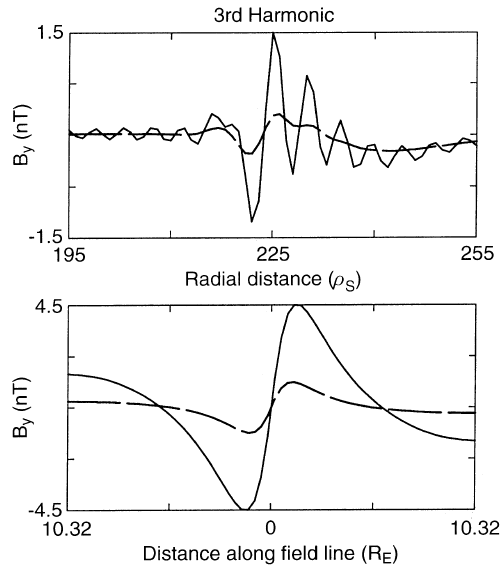
Fig. 3. Profiles of B y along the resonance field line ( bottom ) and transverse to it near the ionosphere ( top ) for the third harmonic dispersive, nonradiative FLR at time 5019 s when the transverse plasma inhomogeneity is weak. Solid curves correspond to the case (cid:82) P (cid:136) (cid:82) P (cid:136) 1 , long-dashed curves correspond to the case S N (cid:82) P (cid:136) (cid:82) P (cid:136) S N